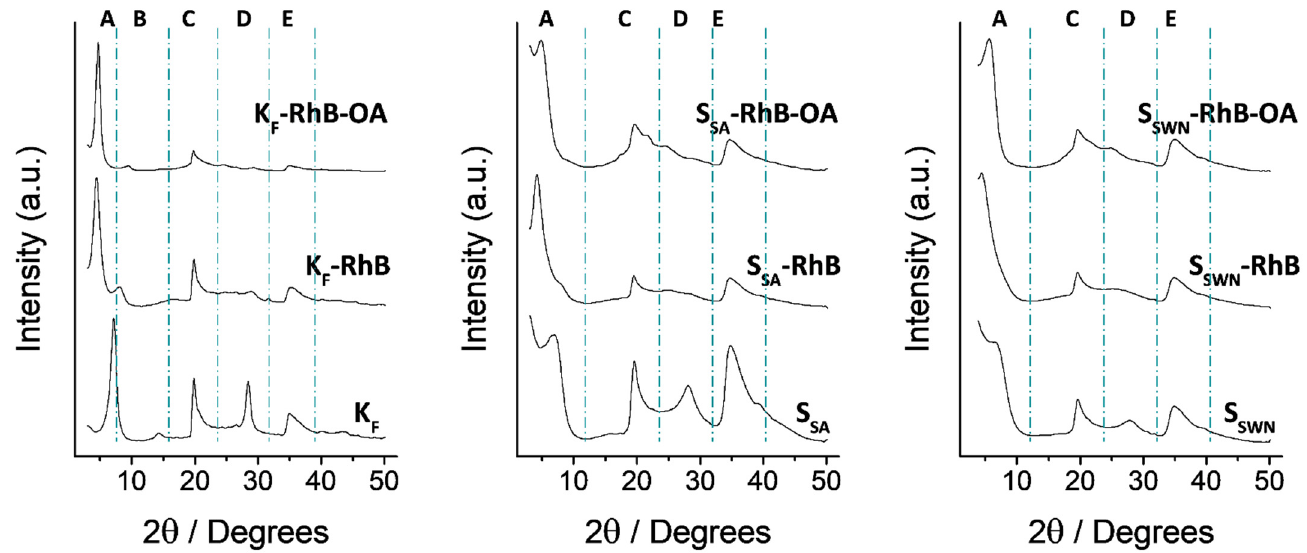
Figure 1. Normalized X-ray patterns of RhB-loaded organonanoclays in the different synthesis steps, indicated in their respective diffractograms. From bottom to top: bare, loaded and final gated material, respectively. The main XRD reflections are labelled from left to right as A–E, consecutively. Table 1. Main reflections’ d-Spacing (Å) values for the RhB-loaded organonanoclays obtained from